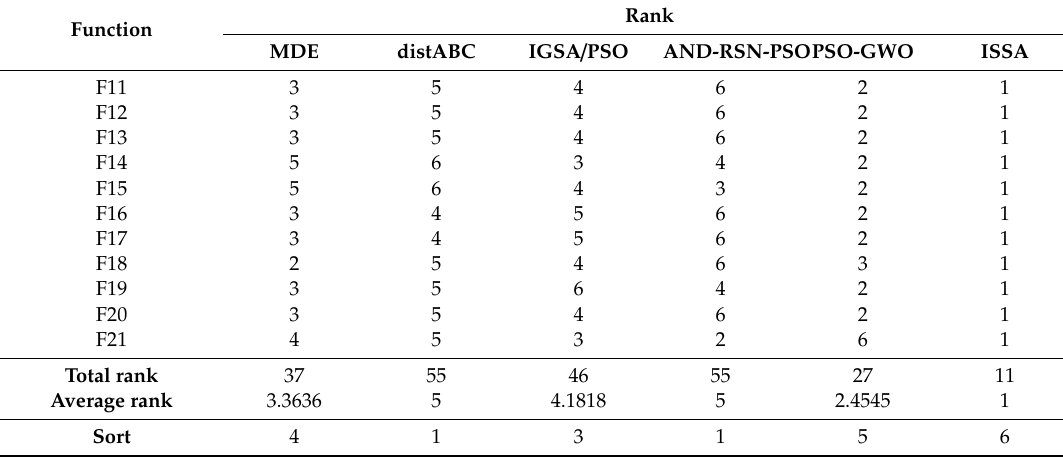
Table 12. The results of the Friedman